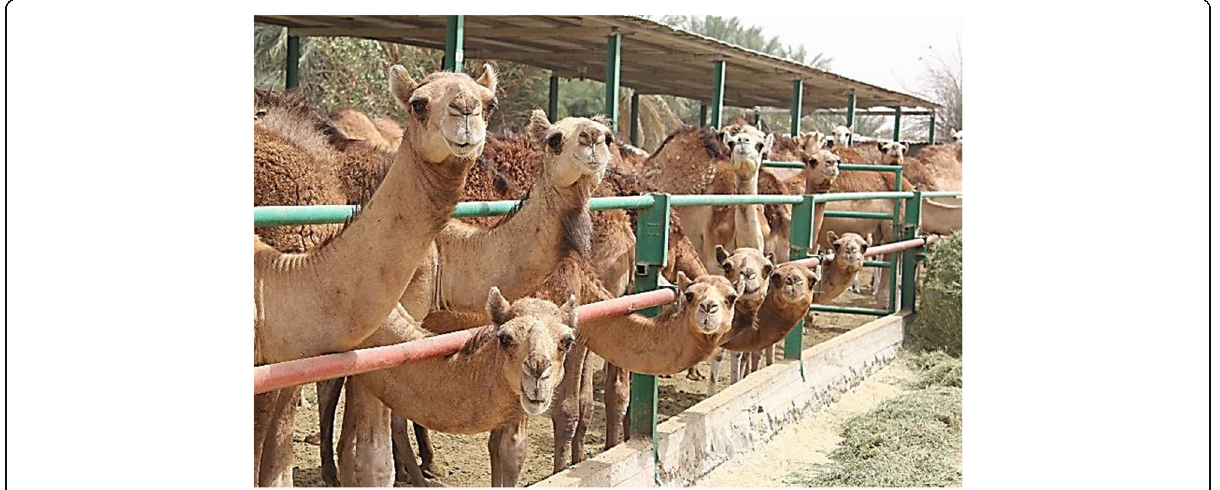
Fig. 12 Camel fattening farm, Kharj, Saudi Arabia (Ph. B.